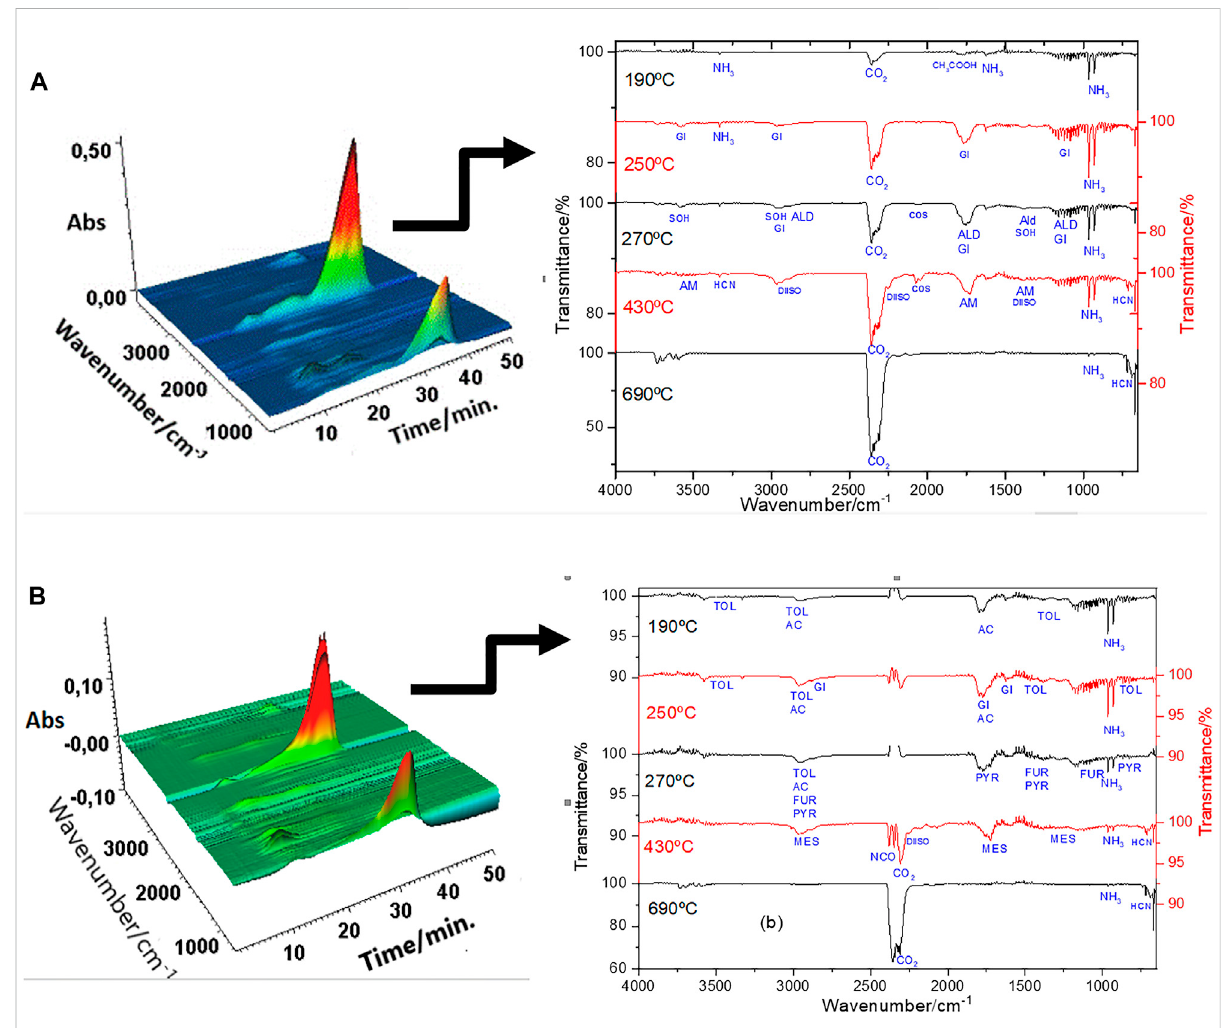
FIGURE 6 FTIR spectra from the gaseous products evolved during the thermal decomposition of (A) CQD a and (B) CQD b